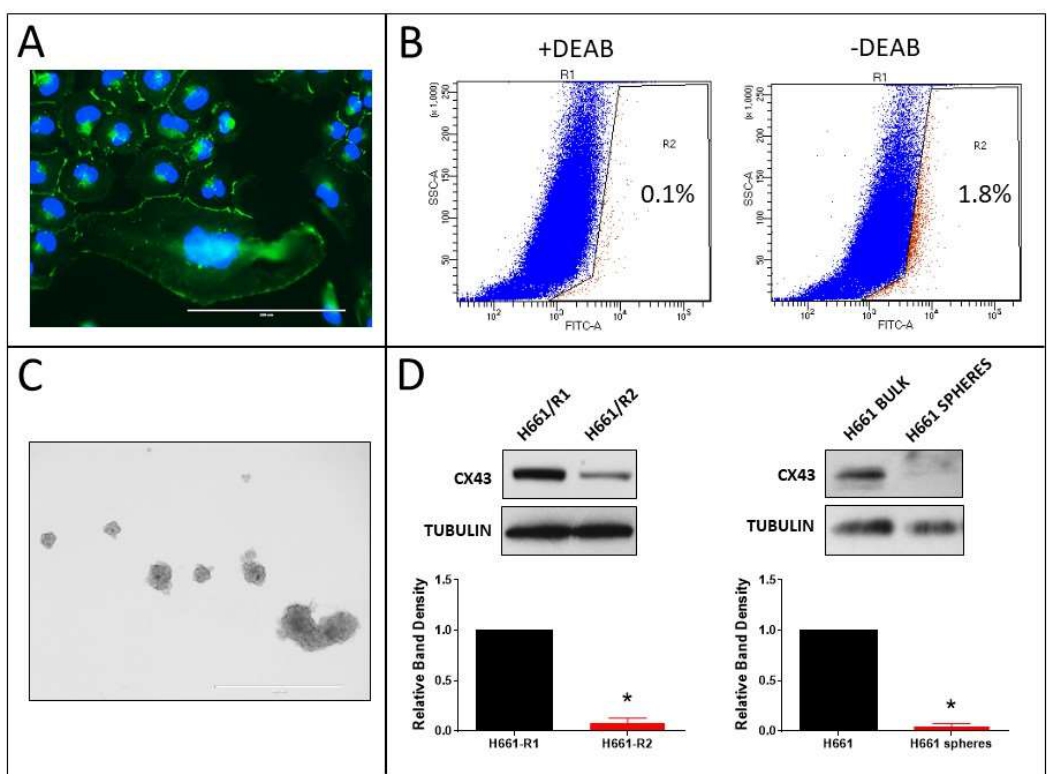
Figure 9. Expression of Cx43 in ALDH-positive cells and tumorspheres derived from H661 cells. ( A ) Cx43 immunostaining (scale bar: 200 µm); ( B ) dot plots of FACS-sorted ALDH-low (R1 pool) and ALDH-high (R2 pool) with and without DEAB (the percentages of R2 cells are shown on the plots); ( C ) H661 tumorspheres (scale bar: 1000 µm); and ( D ) Western blots of Cx43 in R1 (ALDH-low) and R2 (ALDH-high) populations (left blots), and bulk cells and tumorspheres (right blots); Cx43 band densities were normalized to tubulin loading control and to R1 or bulk cells (* p < 0.01 compared to R1 or bulk cells, one-sample t-test, mean ± S.D., n = 3 replicate experiments).